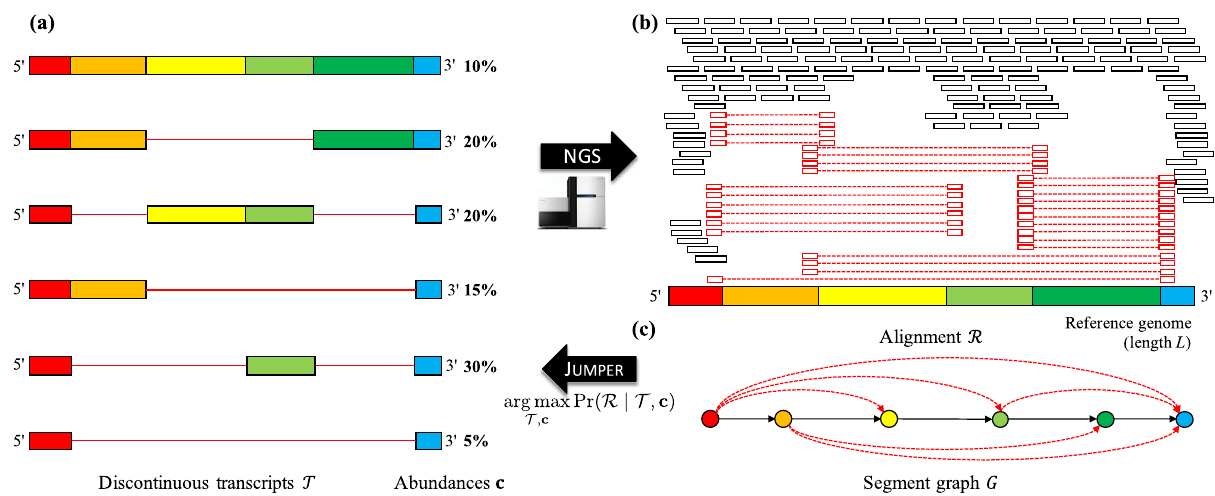
Fig. 1 Overview of Jumper. a Coronaviruses generate a set T of discontinuous transcripts with varying abundances ( c ) during infection. b Next-generation sequencing will produce an alignment R with two types of aligned reads: reads that map to a contiguous genomic region (black) and split reads that map to distinct genomic regions (red). c From R we obtain the segment graph G , a directed acyclic graph with a unique Hamiltonian path. JUMPER solves the DISCONTINUOUS TRANSCRIPT ASSEMBLYto infer T and c with maximum likelihood. While this fi gure shows single-end reads, our problem statement and method make use of the additional information provided by paired-end